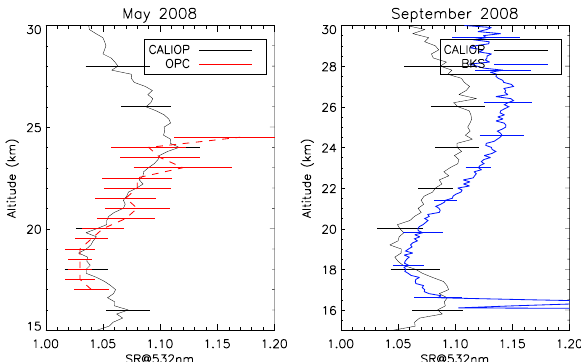
Fig. 3. Left: SR (red) derived from the aerosol size distribution of a balloon-borne Optical Particle Counter at 5 ◦ S in Brazil in May 2008; right: mean scattering ratio reported by BKS sondes at 12 ◦ N in Niger in September 2008; both compared to CALIOP SR within a box of ± 7 ◦ latitude ± 70 ◦ longitude centred at the location of the balloon